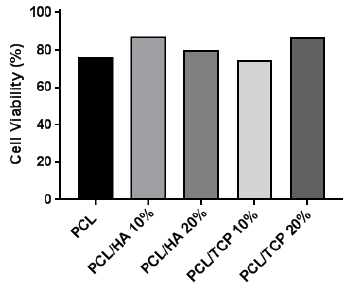
Figure 7 . Cell viability (%) for all scaffolds at day 1.